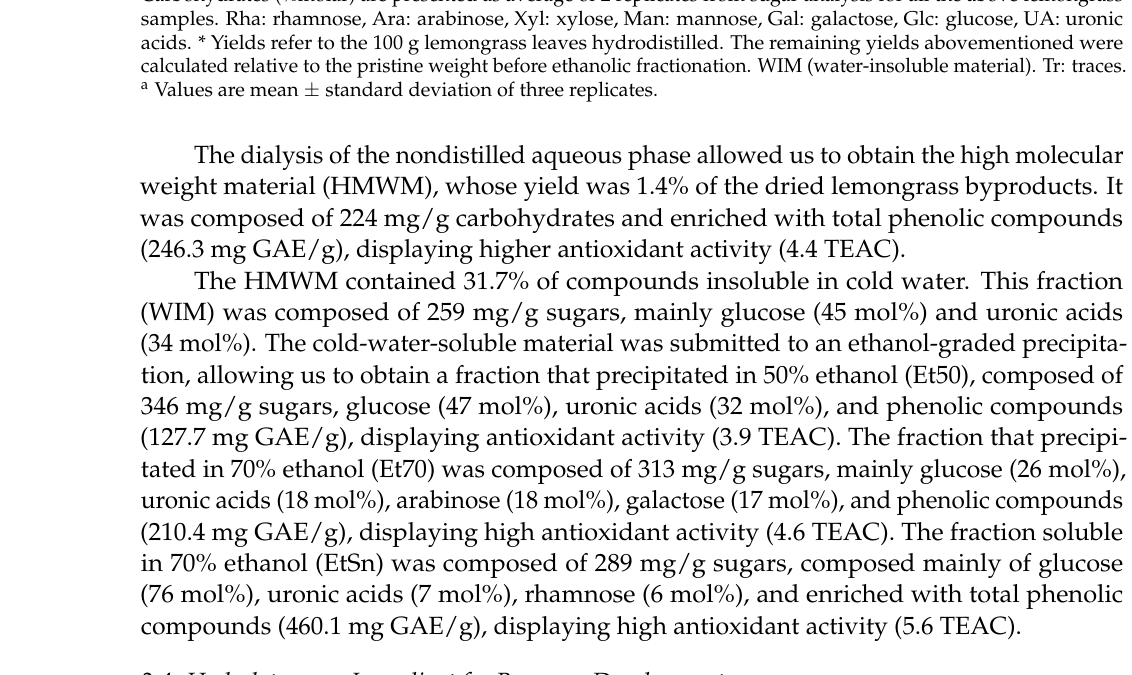
Carbohydrates (%molar) are presented as average of 2 replicates from sugar analysis for all the above lemongrass samples. Rha: rhamnose, Ara: arabinose, Xyl: xylose, Man: mannose, Gal: galactose, Glc: glucose, UA: uronic acids. * Yields refer to the 100 g lemongrass leaves hydrodistilled. The remaining yields abovementioned were calculated relative to the pristine weight before ethanolic fractionation. WIM (water-insoluble material). Tr: traces. a Values are mean ± standard deviation of three